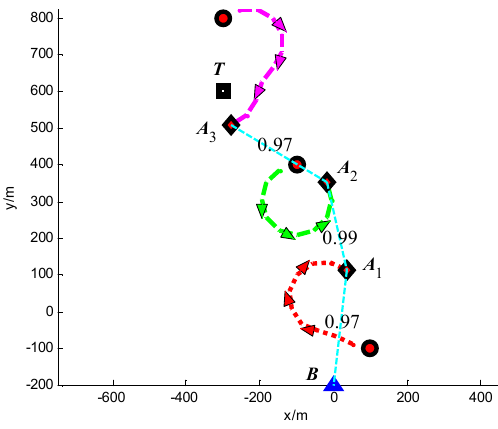
Figure 33. Trajectories of UAVs at t = 10 s (Scenario 4). Appl. Sci. 2018 , 8 , x FOR PEER REVIEW